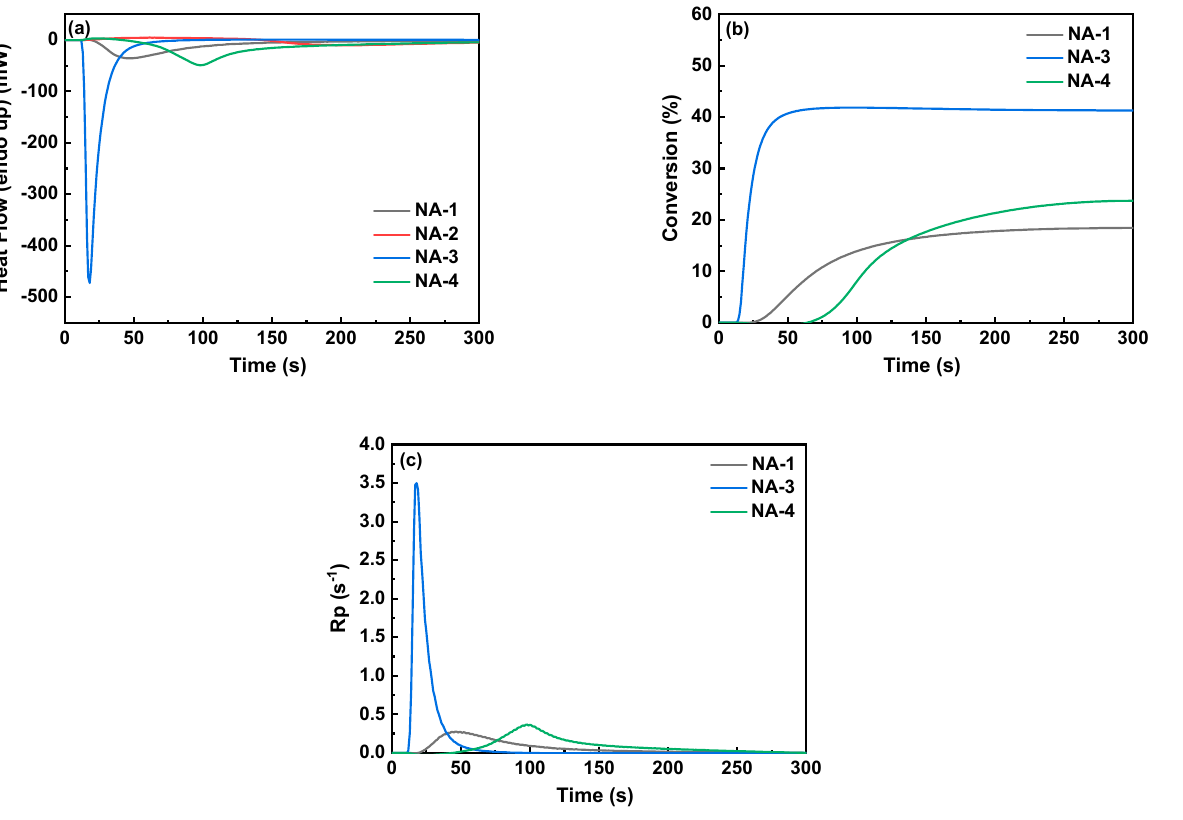
Figure 7. ( a ) Heat flow, ( b ) degree of conversion, and ( c ) Rp versus time for TMPTA photopolymer-